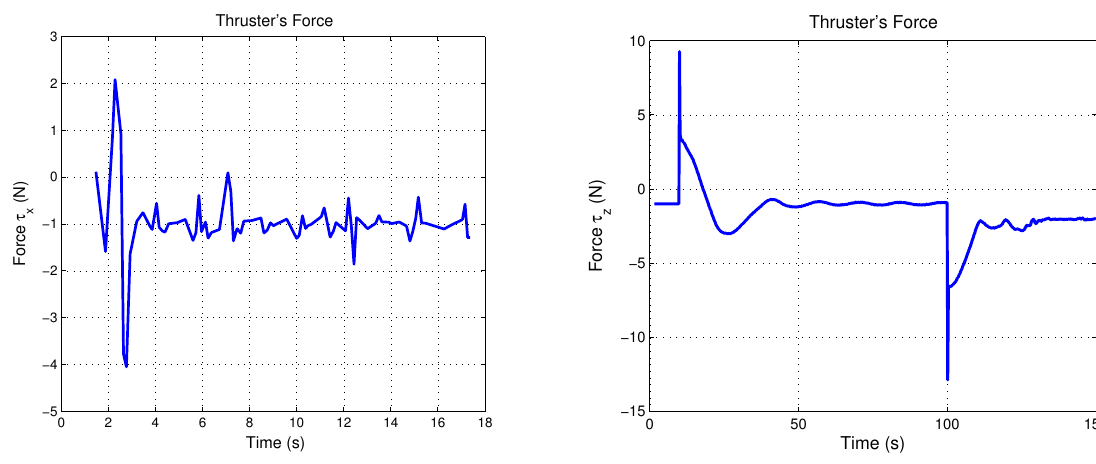
Figure 14. Experimental reaction of the torques on the x - and z